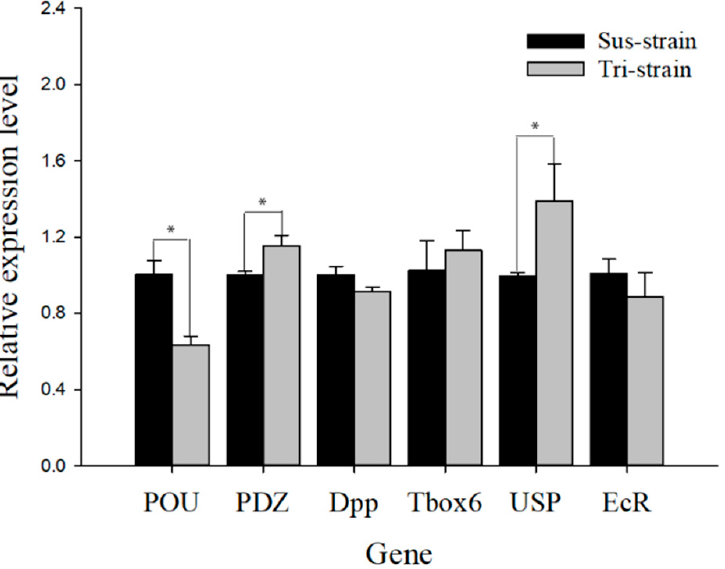
Figure 2. The relative expression levels of transcription factors related to growth and reproduction of S. furcifera were obtained from the third-instar nymphs of the Tri-strain. * shows significance at p < 0.05 level with Student’s t -test. adults of the Tri-strain compared with the Sus-strain (1.71-, 1.40-, 1.39-, 1.15- and 1.39-fold in the midgut, thorax, ovary, head and foot, respectively), which is consistent with the increases in the nymph (Figure S2). The gene expression of USP was measured using qRT-PCR, and we found that the expression of USP was upregulated in a gradient manner (Figure S3), which proved that the expression trend of USP was positively correlated with drug resistance. These results suggest that the upregulation of USP expression may result mainly in increased fecundity in the